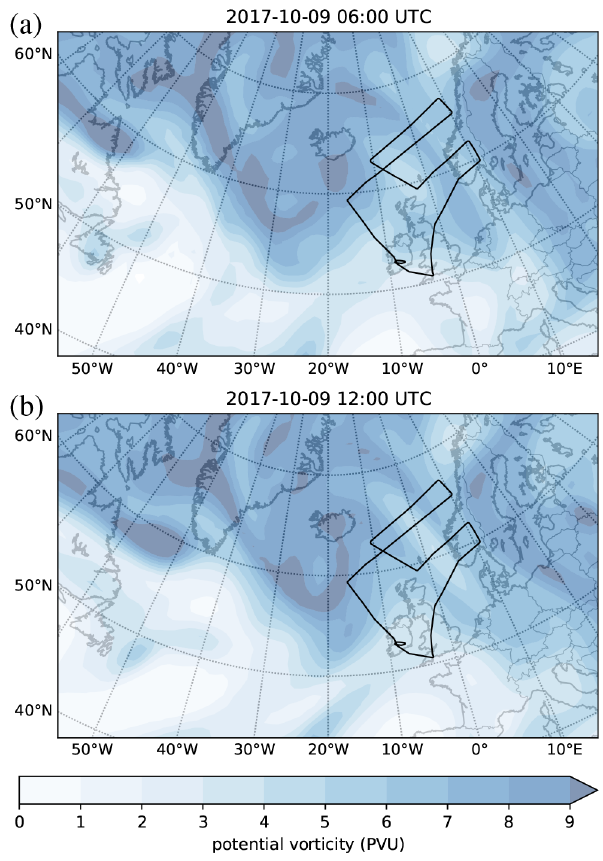
Figure D2. Potential vorticity at 340K potential temperature level, 9 October. Black lines show flight